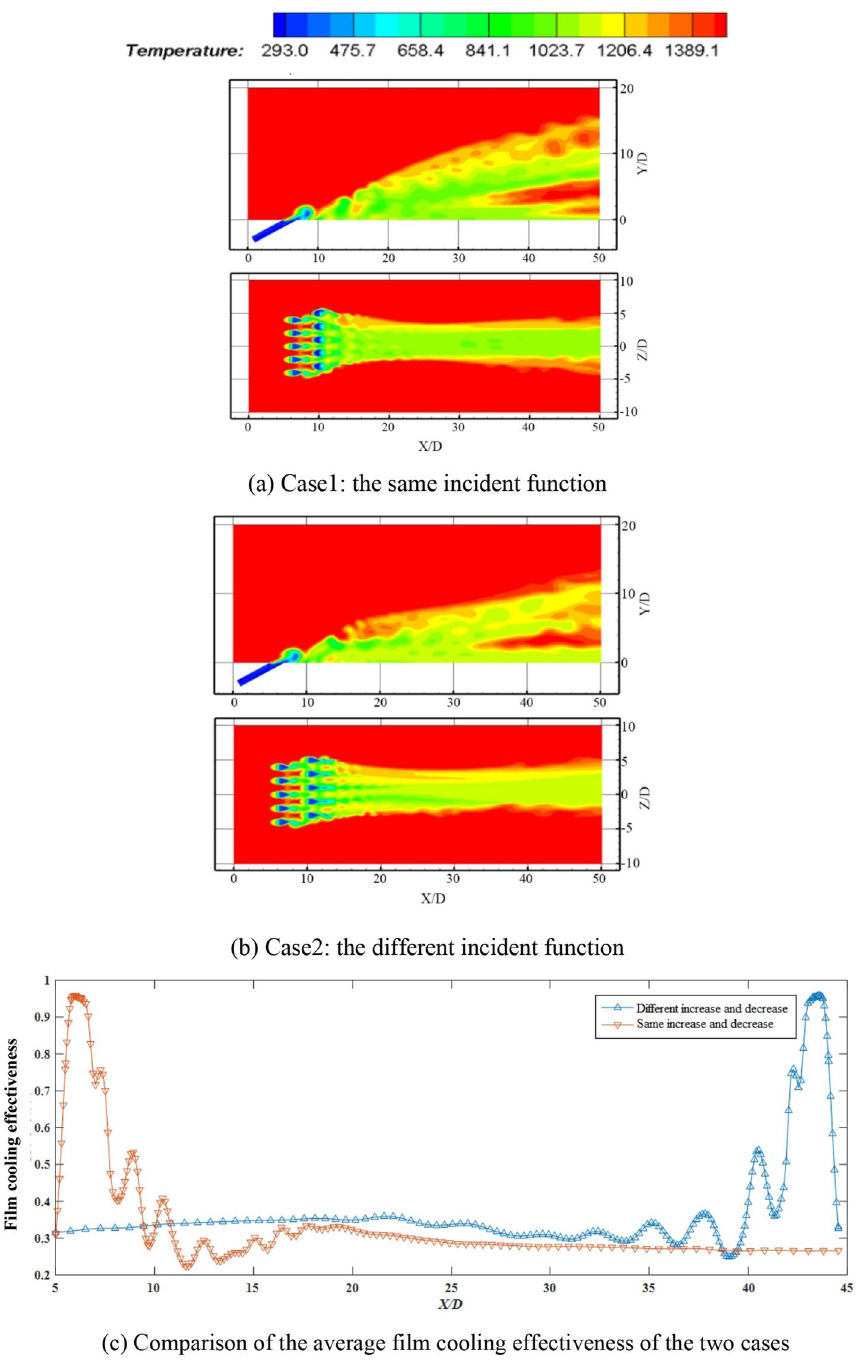
Figure 7. Temperature contours and comparison of the average film cooling effectiveness of the two incident modes of incident modes of the inserted dual-row at 30° incidence and St =